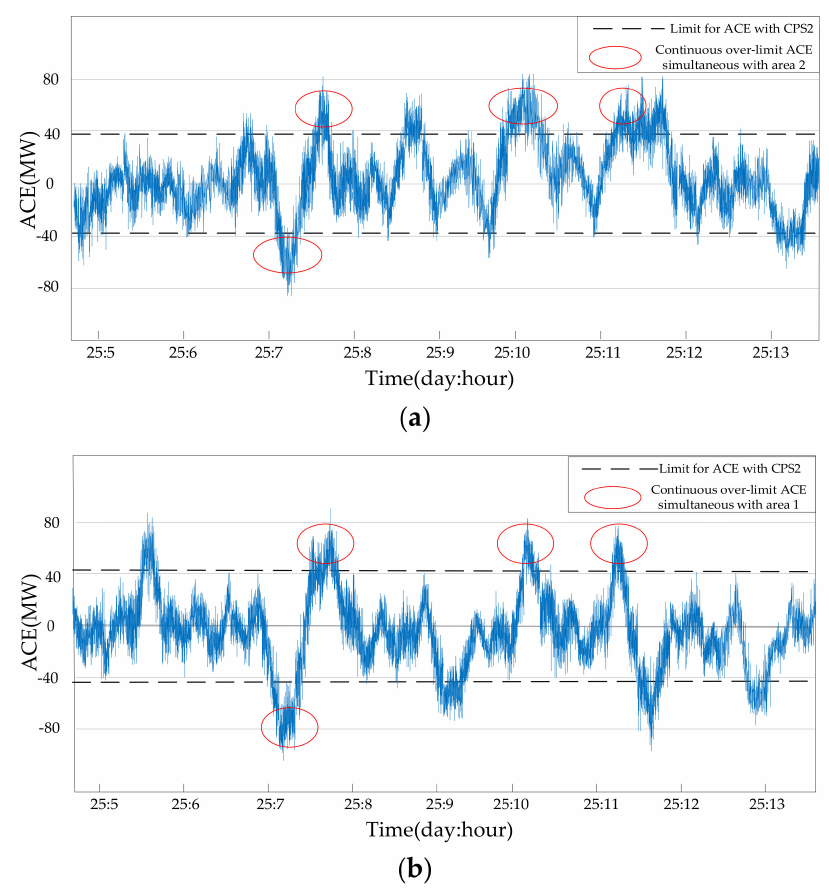
Figure 8. Two ACEs’ fluctuations during some time with the CPS1&CPS2 logic: ( a ) area 1; ( b ) area 2. With the BAL-001-2 logic, the distribution of occurrences of different continuous minutes that the over-limit ACE and the over-limit frequency last for is shown in Figure 9. The longest time that the two ACEs remain out of their limits is, respectively, 21 min and 23 min. The longest duration that the over-limit frequency lasts for is 16 min. Thus, the areas’ control performance is considered to meet the Standard BAL-001-2 requirement and the short-time operation security can be maintained as well. These good results are mainly due to the management and regulation of the proposed TM-GR logic.